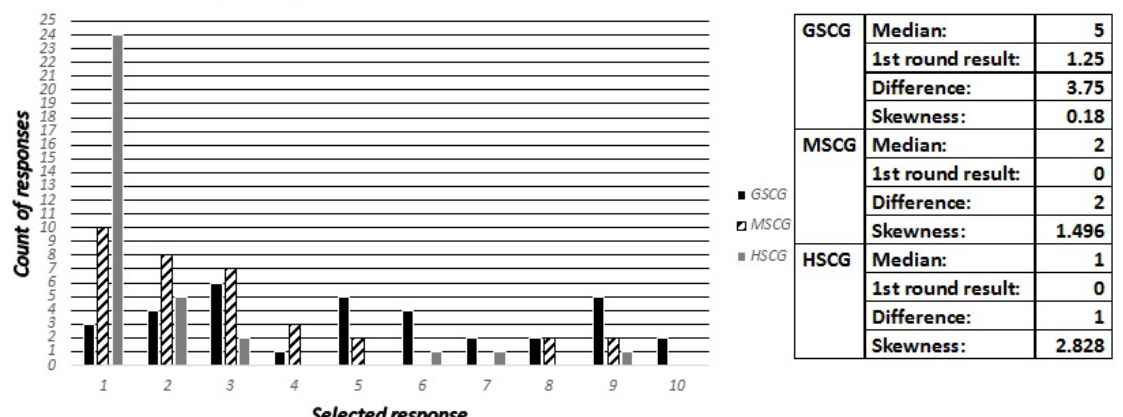
Figure 16. Expert predictions for question 11,